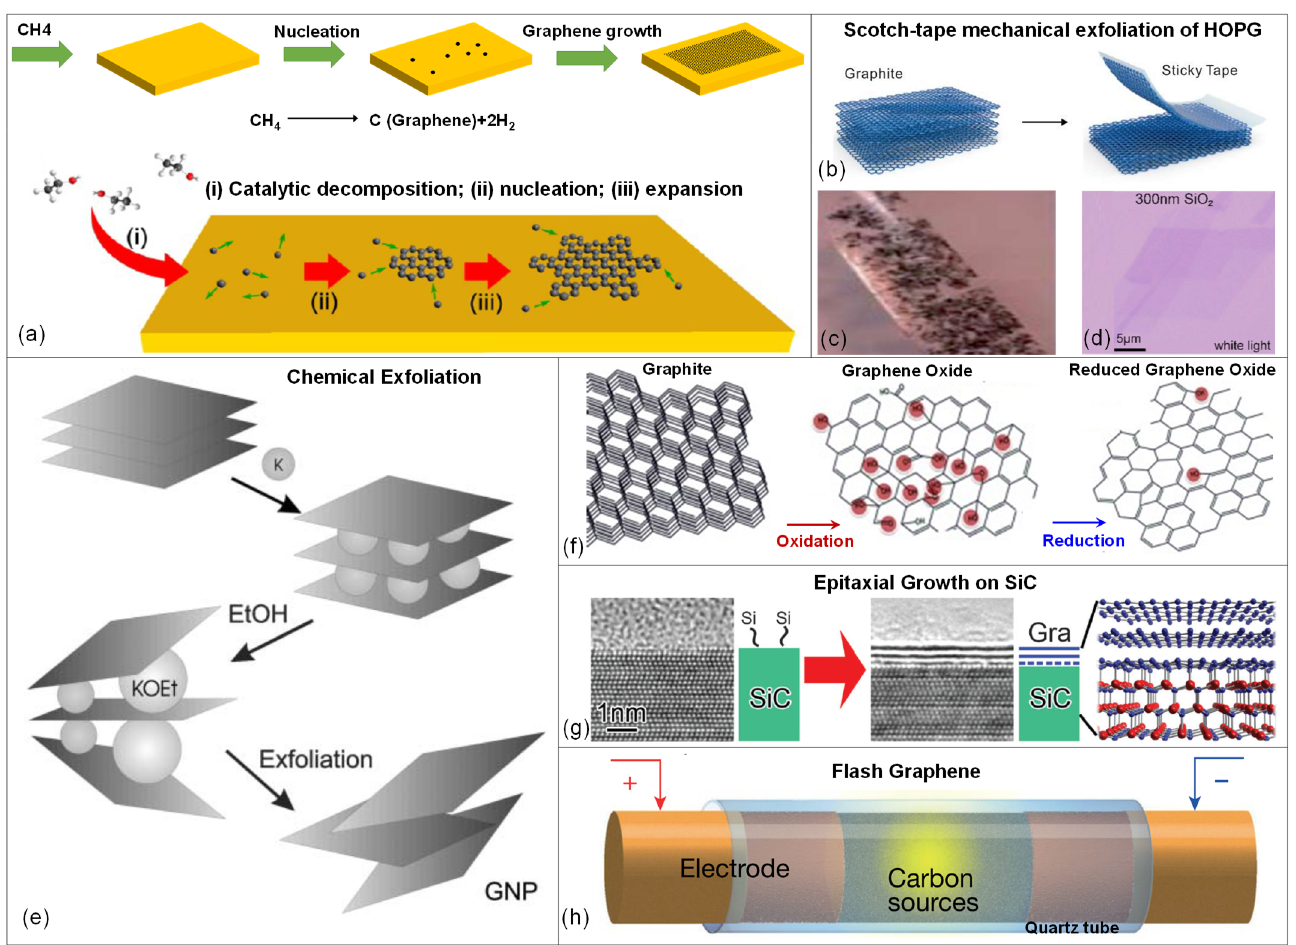
Figure 3. Methods for synthesizing graphene ( a ) Schematic of the initial state growth of graphene on copper from ethanol-CVD method. “Adapted with permission from ref. [90]. Copyright (2013) American Chemical Society.” ( b ) Schematic illustration of the mechanical exfoliation [92]. ( c ) An image of graphene flakes on scotch tape [93]. ( d ) Optical microscopy image of relatively large few layers of transferred graphene flakes on a SiO 2 /Si. “Reprinted from ref. [94], with the permission of AIP Publishing.” ( e ) Schematic diagram of chemical exfoliation by ethanol to form graphene nano plates [95]. ( f ) The schematic diagram of reducing graphene oxide to develop reduced graphene oxide [96]. ( g ) Epitaxial growth of graphene on a SiC wafer [97]. ( h ) Schematic of flash Joule heating (FJH) [79].